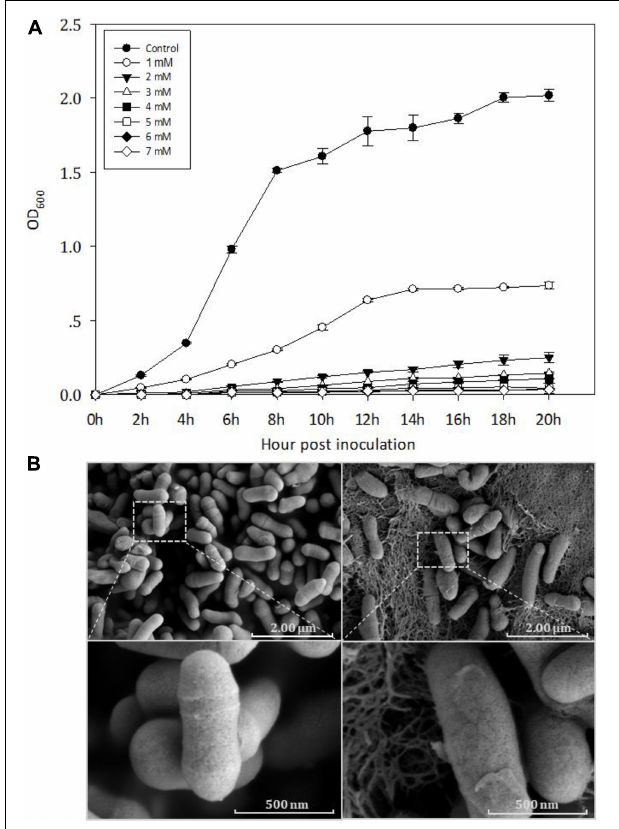
FIGURE 1 | (A) Growth curves of Y8 exposed to Cd of different concentrations; (B) scanning electron microscope (SEM) images of Y8’s cell morphology without (left) and with Cd (right, 4